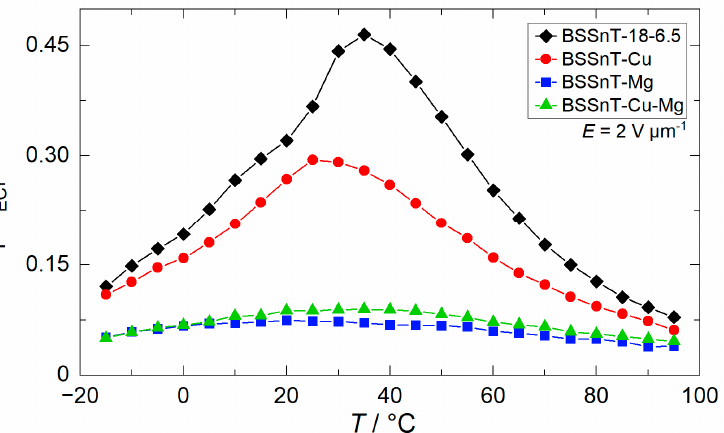
Table 4. Compilation of maximum electrocaloric temperature change ( |Δ𝑇 (cid:2889)(cid:2887) | ) measured at an elec- tric fi eld change ( Δ𝐸 ) of 2 V µm − 1 , corresponding temperature ( 𝑇 ), dielectric breakdown strength ( 𝐸 (cid:2912)(cid:2914) ) and speci fi c heat capacity ( 𝑐 (cid:3043) ) at zero electric fi eld.